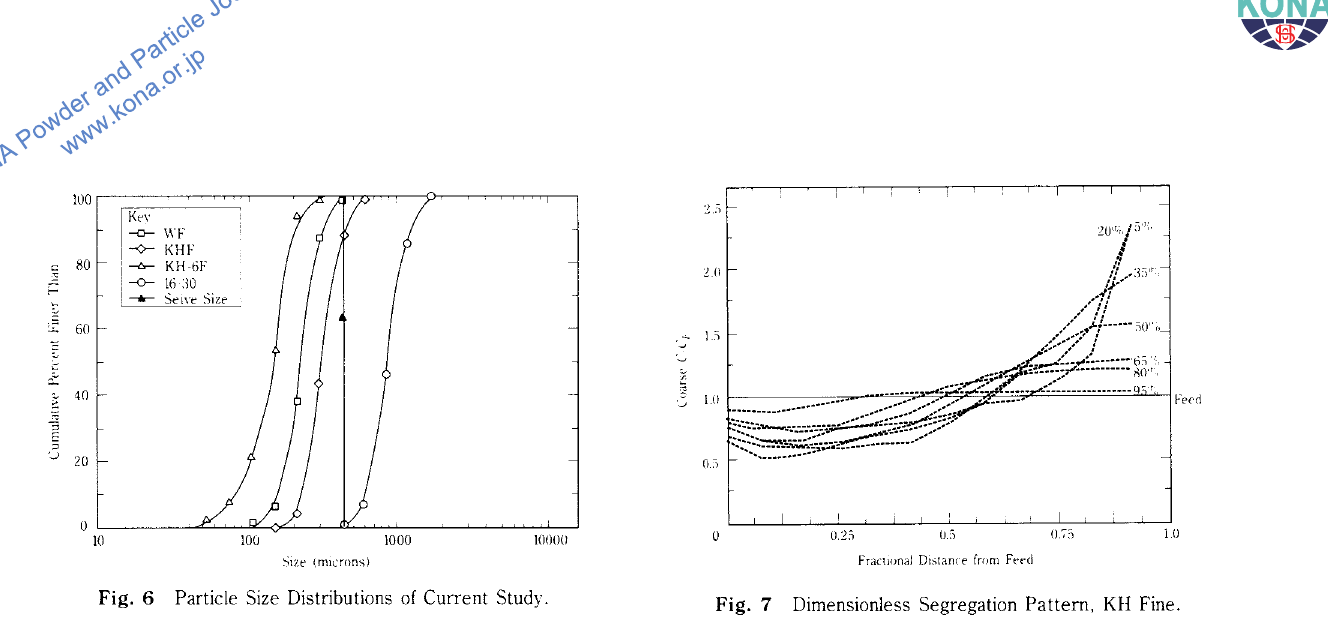
Fig. 6 Particle Size Distributions of Current Study. Fig. 7 Dimensionless Segregation Pattern, KH Fine.